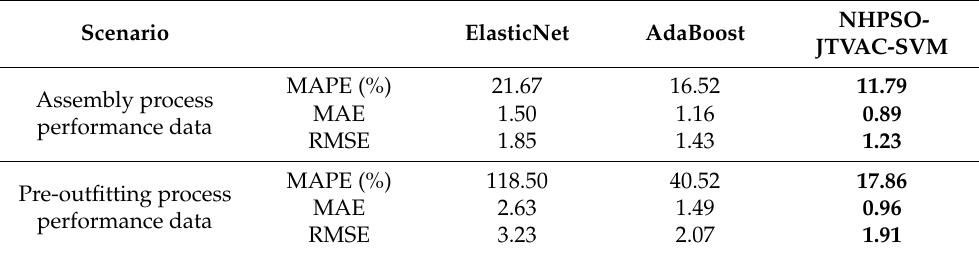
Table 9. Comparison with other machine